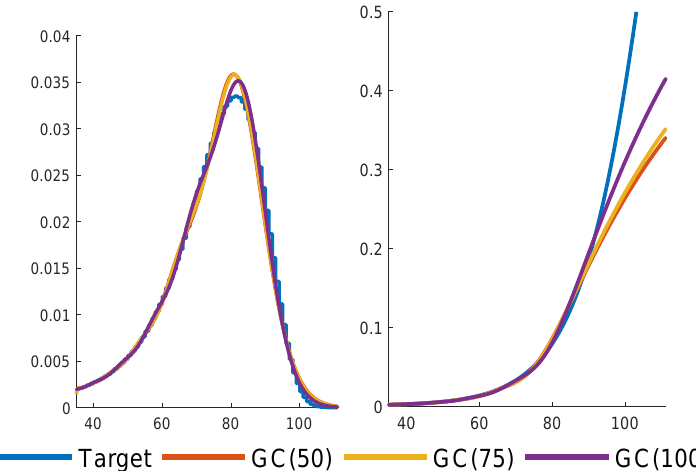
Figure 6. Probability density functions and hazard rate functions for the life table and GC fits with p = 50,75,100